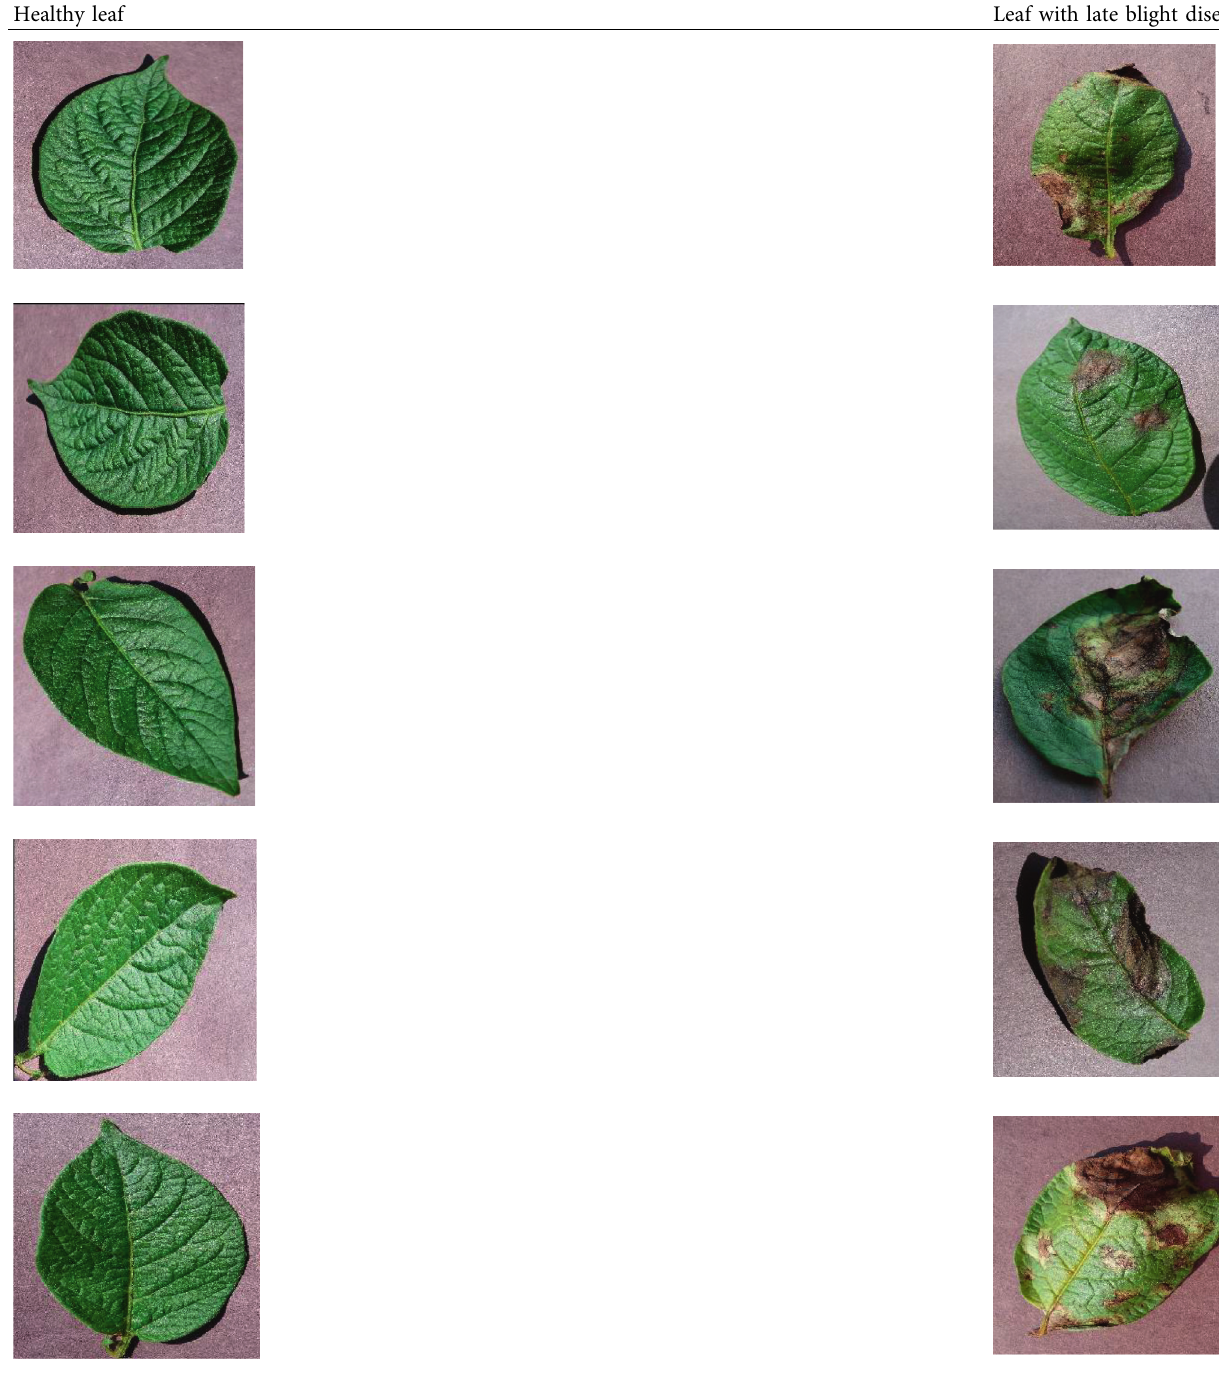
Table 3: Potato plant leaf with disease (source: PlantVillage data set